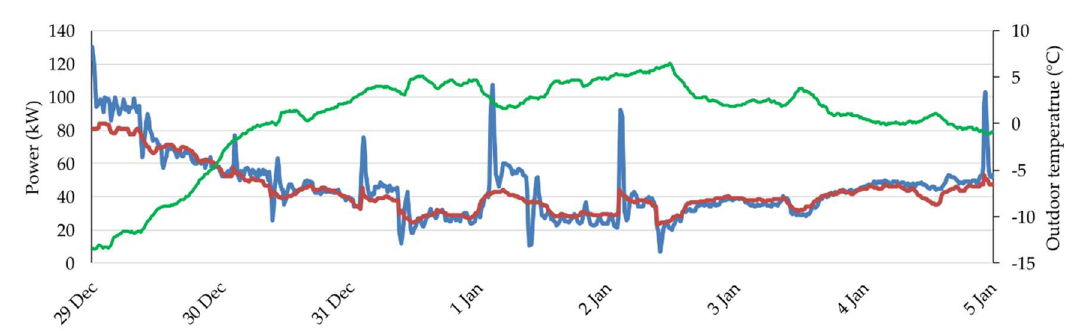
Figure 8. Measured (blue line) and simulated (red line) energy to the hydronic radiators and outdoor temperature (green line) during the unoccupied validation period.